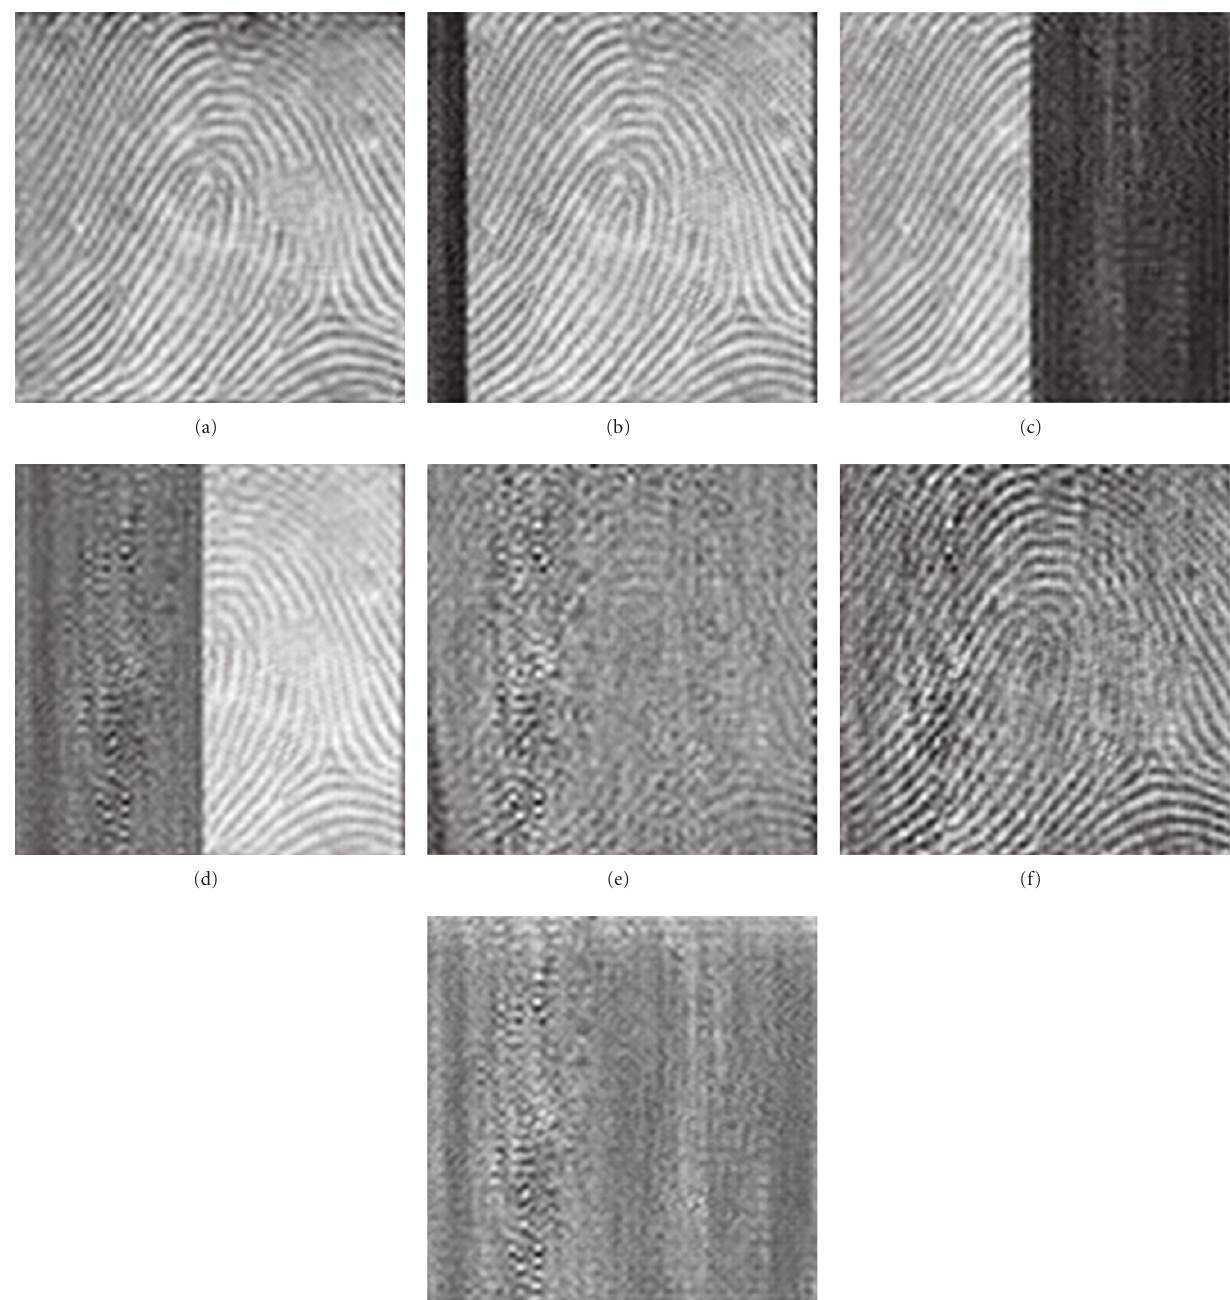
Figure 16: Recovered watermarks from Lena image under geometric attacks (a) cropping half top (NC = 0 . 9759) (b) cropping 400 × 450 (NC = 0 . 9398) (c) cropping half right (NC = 0 . 6697) (d) cropping half left (NC = 0 . 7260) (e) rotation (angle = 20 o ) (f) scaling (factor = 2) (g) cropping half down (NC = 0 .